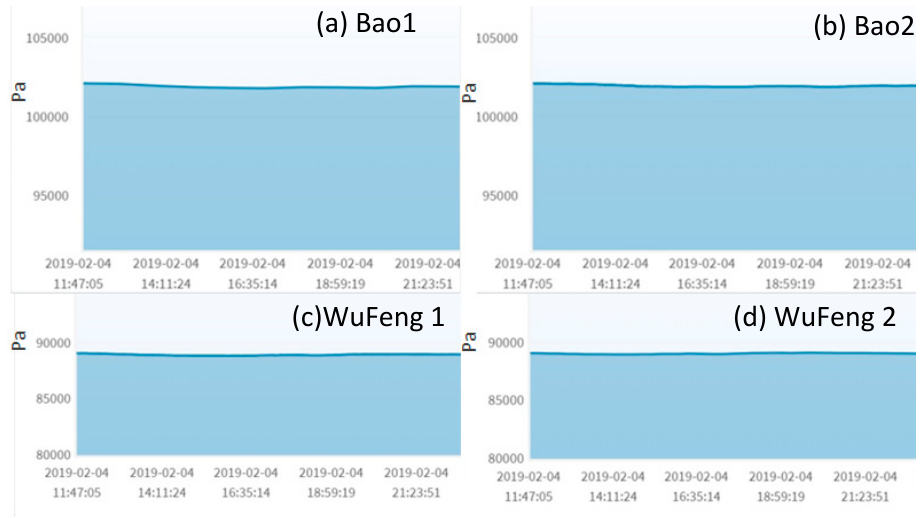
Figure 4. Barometric